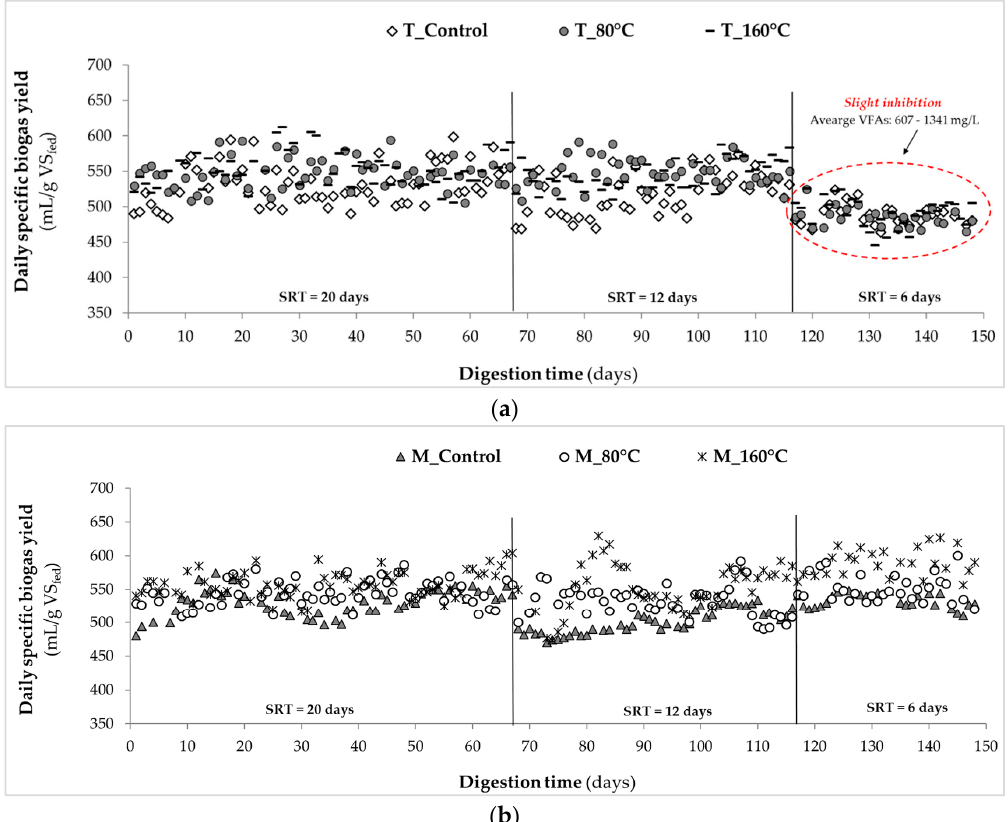
Figure 3. The evolution of anaerobic digesters’ specific biogas yields (0 °C, 1 atm) under ( a ) thermophilic, and ( b ) mesophilic conditions at sludge retention times (SRTs) of 20, 12, and 6 days during steady-state.